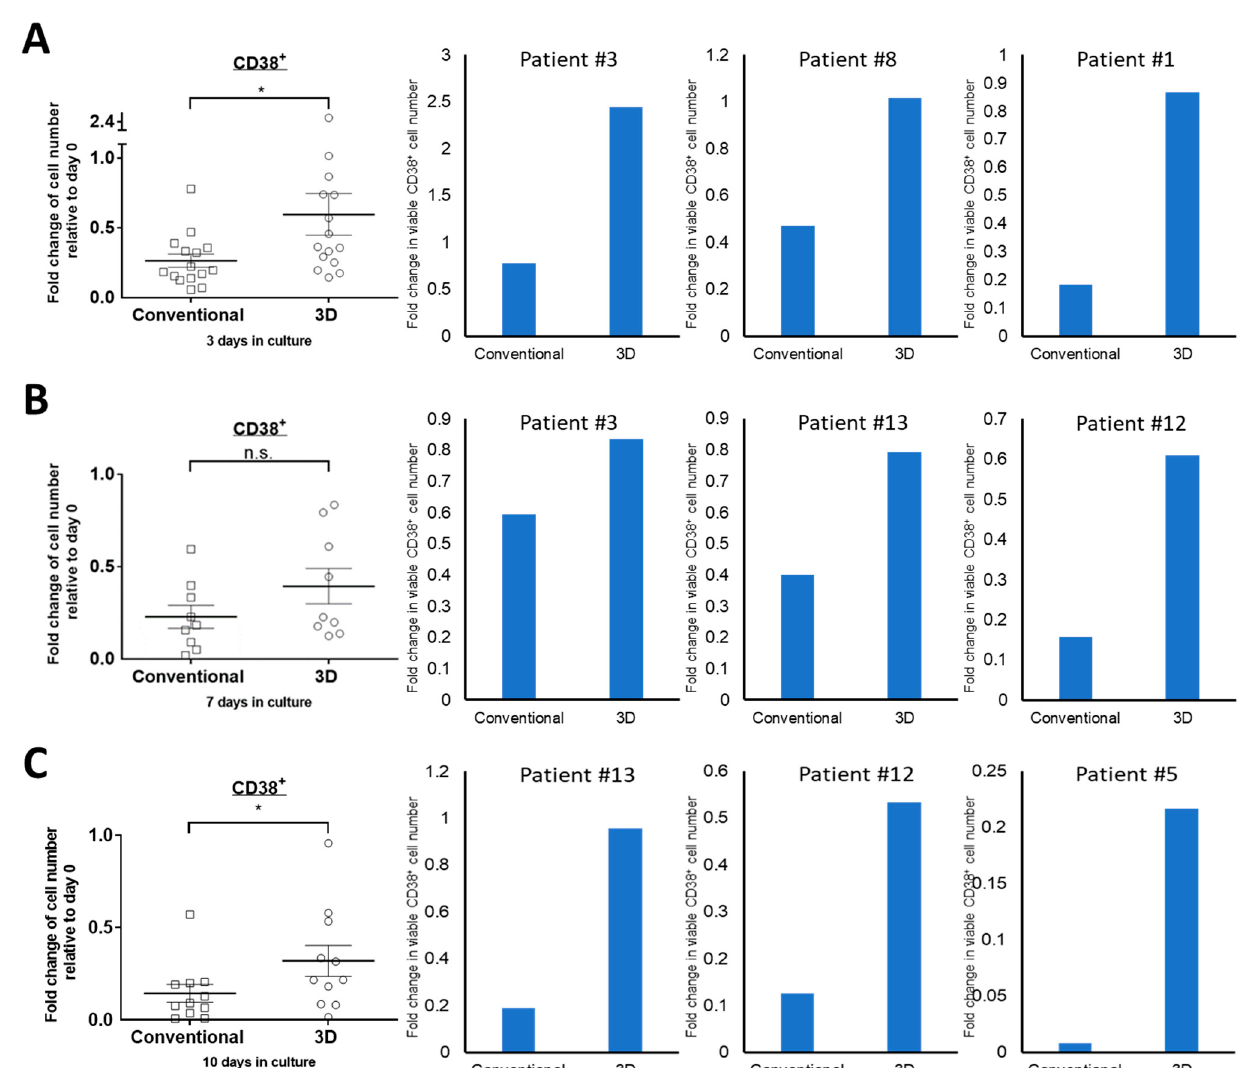
Figure 1. PM cells are better preserved in 3D culture compared to conventional culture. Fold change of viable CD38+ cell numbers from MM patients in conventional or 3D culture on ( A ) day 3 ( n = 15), ( B ) day 7 ( n = 11) and ( C ) day 10 ( n = 11) relative to day 0. The mean values were indicated with error bars representing standard error. * p < 0.05, paired Student’s t -test.